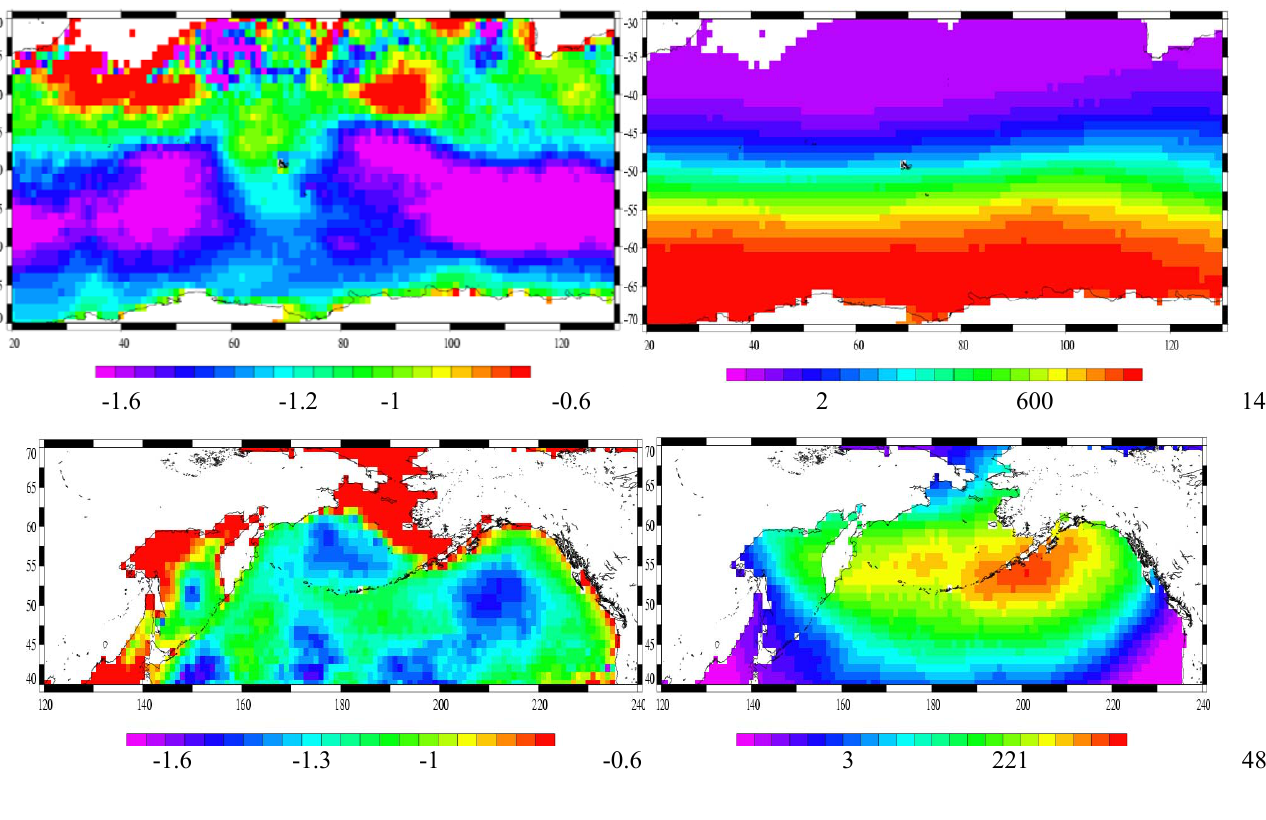
Figure 15. Upper panel is Indian ocean, lower panel is north Pacific ocean. Left: regression coefficient A between SLP and MOG2D sea level (hPa/cm). Right: number of cases with DP <